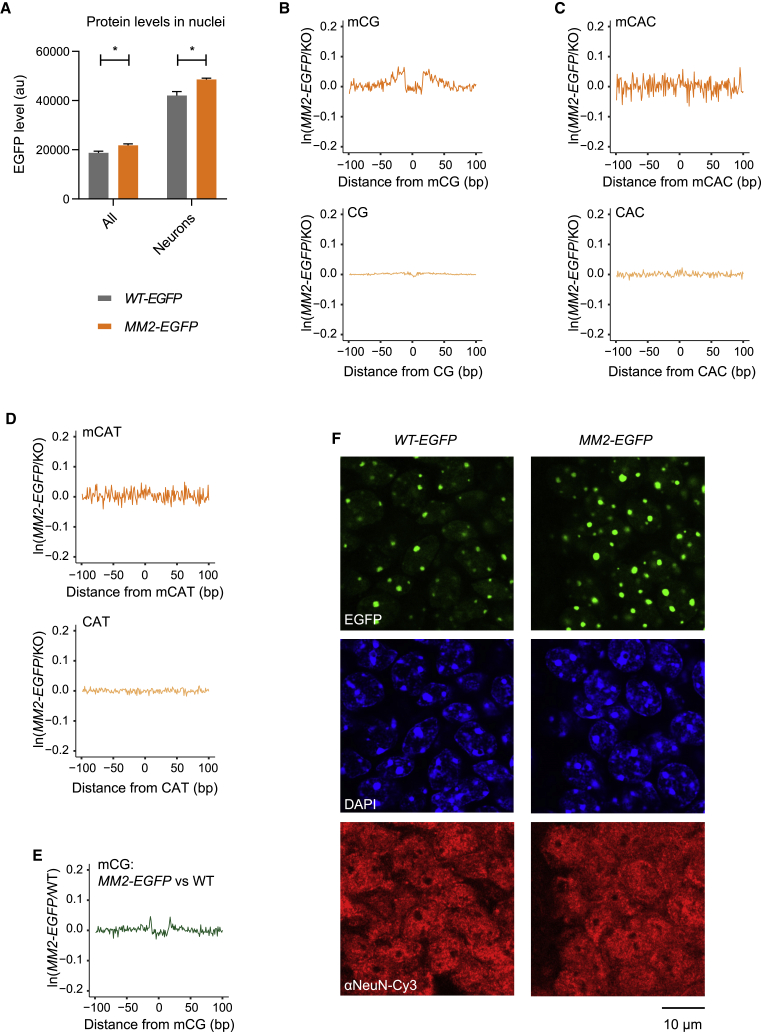
MM2 binds mCG but not mCAC or mCAT in vivo(A) Flow cytometry analysis of protein levels in nuclei from whole brain (All) and the high-NeuN subpopulation (Neurons) in WT-EGFP (n = 3) and MM2-EGFP (n = 3), detected using EGFP fluorescence. Graph shows means ± SEMs, and genotypes were compared by t tests. All: MM2-EGFP levels are 116% ± 0.03% of WT-EGFP, ∗p = 0.030; Neurons: 116% ± 0.01% of WT-EGFP, ∗p = 0.018; au, arbitrary units.(B–D) ATAC-seq footprinting analysis of MM2-EGFP over methylated (top) and unmethylated (bottom) CG (B), CAC (C), and CAT (D) sites in the mouse hypothalamus. Equivalent WT ATAC-seq footprinting is shown in Figures 1D–1F.(E) Direct comparison of ATAC-seq profiles over mCG sites between MM2-EGFP and WT samples.(F) WT-EGFP and MM2-EGFP are both localized at mCG-rich pericentromeric heterochromatin in the brains of knockin mice (representative images of the dentate gyrus of the hippocampus). WT-EGFP and MM2-EGFP were visualized by EGFP fluorescence, heterochromatic foci appear as DAPI bright spots, and NeuN staining shows neuronal nuclei. Scale bar, 10 μm.